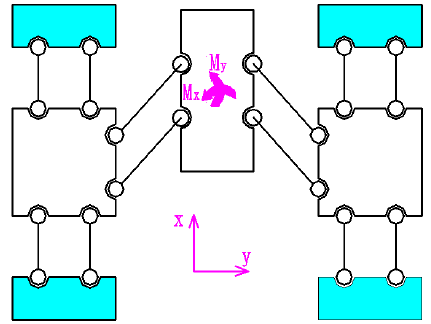
Figure 6. Common force conditions during work.